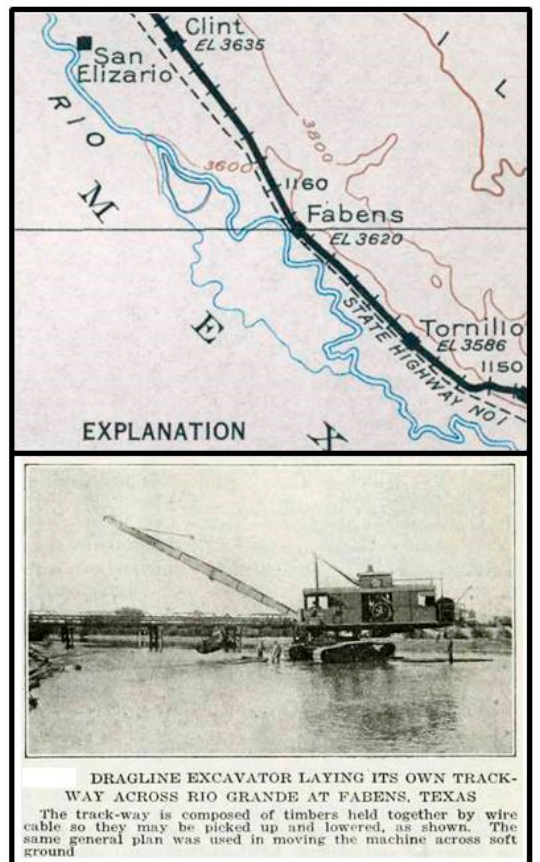
Figure 10. The historic path of the main Rio Grande channel near Fabens in the early 1930s is shown in Sheet 17 in Darton [35]. A photo published in Burkholder [37] depicts excavation works at the main Rio Grande channel near Fabens.